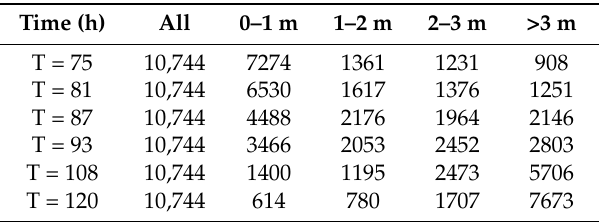
Table 5. Numbers of grids with respect to different inundation depths obtained from the simulation model over time for Event 7.